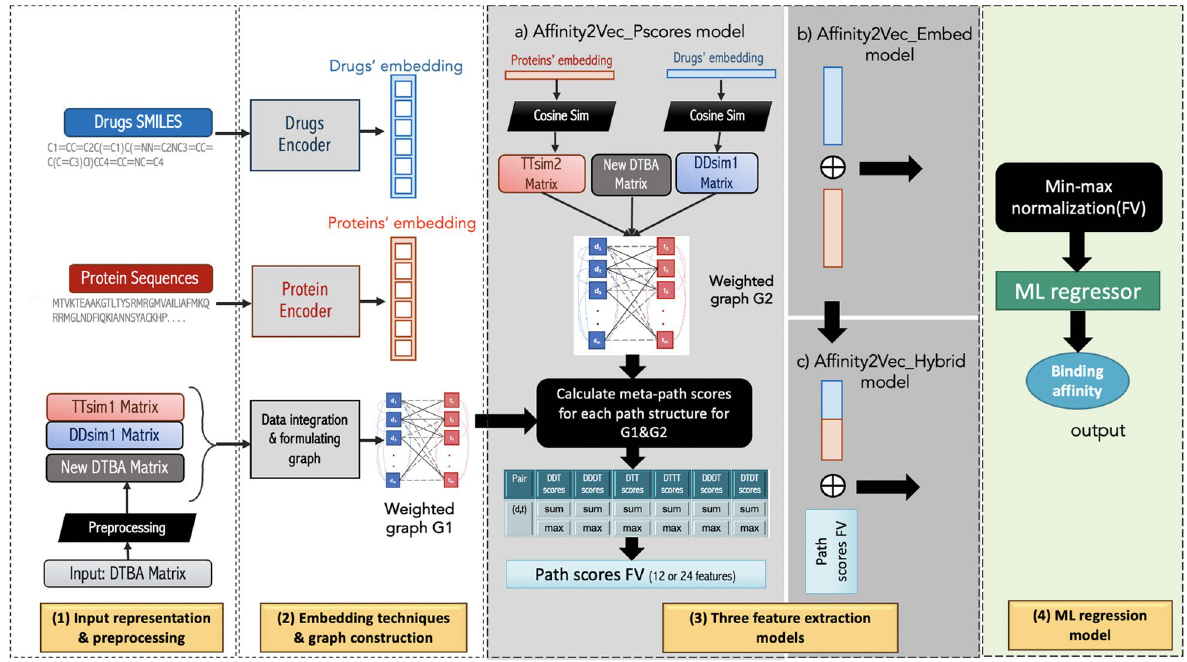
Figure 1. The pipeline of Affinity2Vec, which consists of four main steps and three models for feature extraction a, b, and